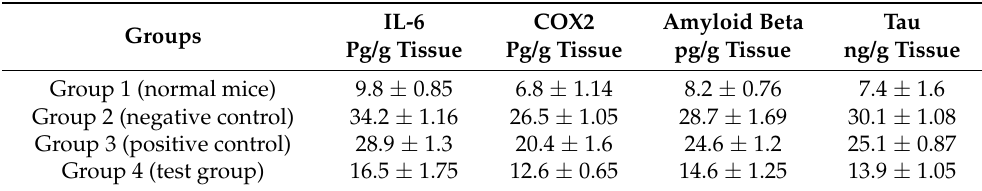
Table 2. Results of neurochemical assay of different biomarkers measured after homogenization of mice brain obtained from different groups. IL-6 COX2 Amyloid Beta Groups Pg/g Tissue Pg/g Tissue pg/g